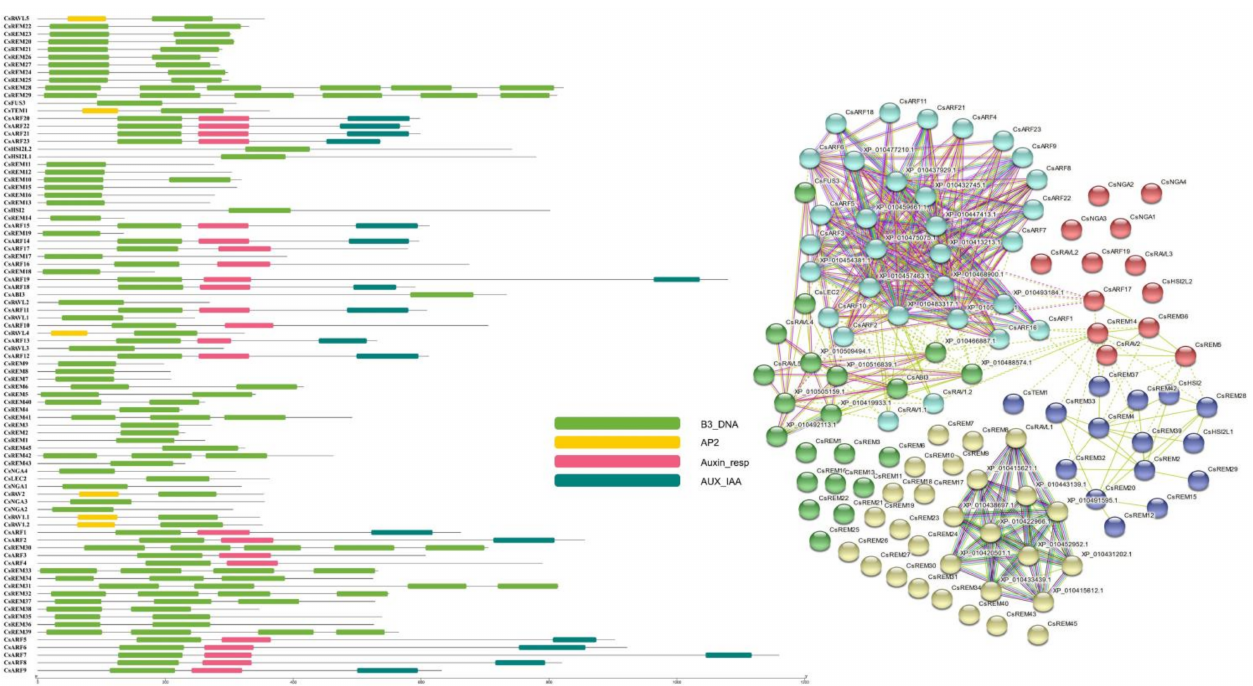
Figure 4. A conserved domain analysis of the B3 genes is presented on the left panel of the picture, and the protein–protein interaction is shown on the right